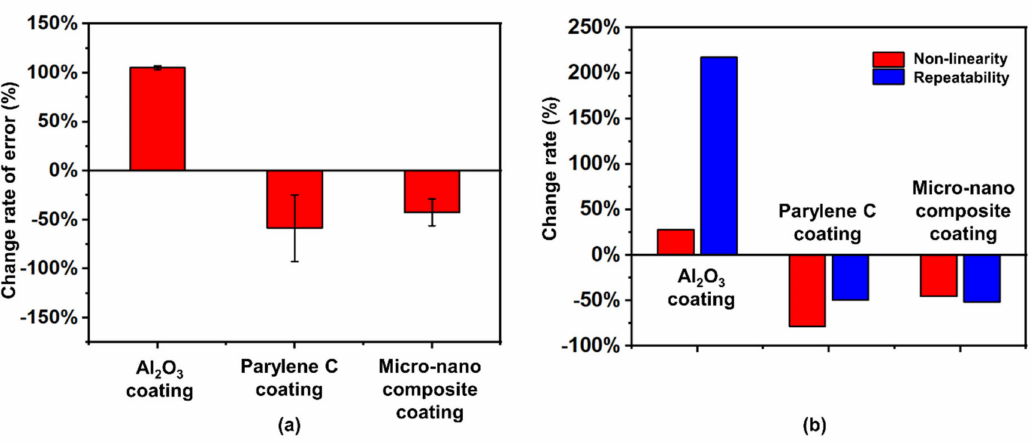
Figure 4. ( a ) Change rate of error of the device before and after encapsulation in different control groups; ( b ) change rate of the device performance parameters before and after different